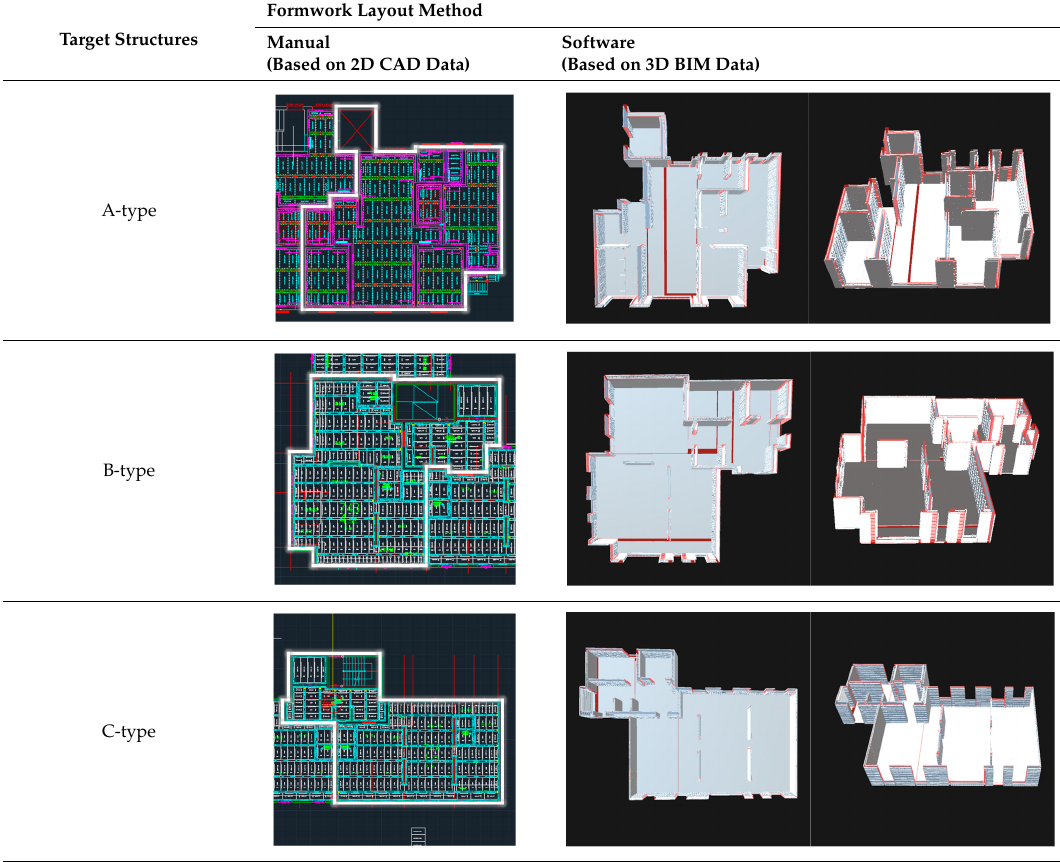
Table 2. Formwork layout images.